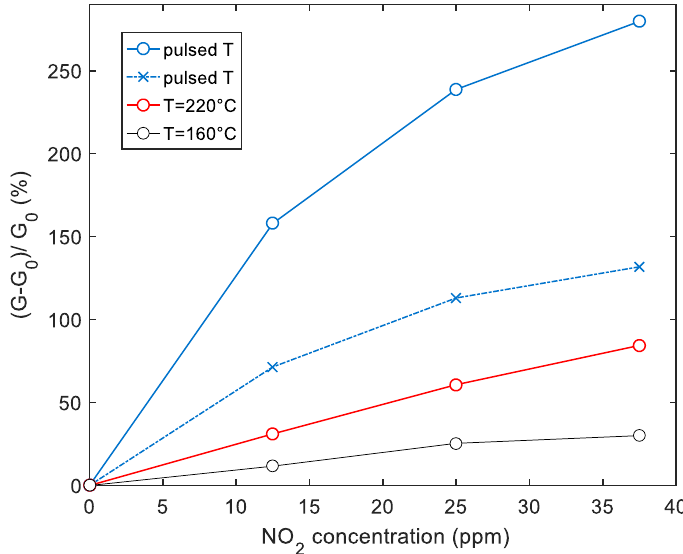
Figure 9. Simulated response of the sensor decorated with TiO 2 to NO 2 as a function of the NO 2 concentration according to the selected temperature profile (shown in Figure 8). ×-blue markers: Results obtained by sampling the sensor response at the end of the last T high pulse of each NO 2 injection phase. O-blue markers: Results obtained by sampling the sensor response at the end of the last T low pulse of each NO 2 injection phase, as shown in Figure 8. Red and black lines are the responses obtained at the end of each NO 2 injection phase at a constant temperature as per legend.